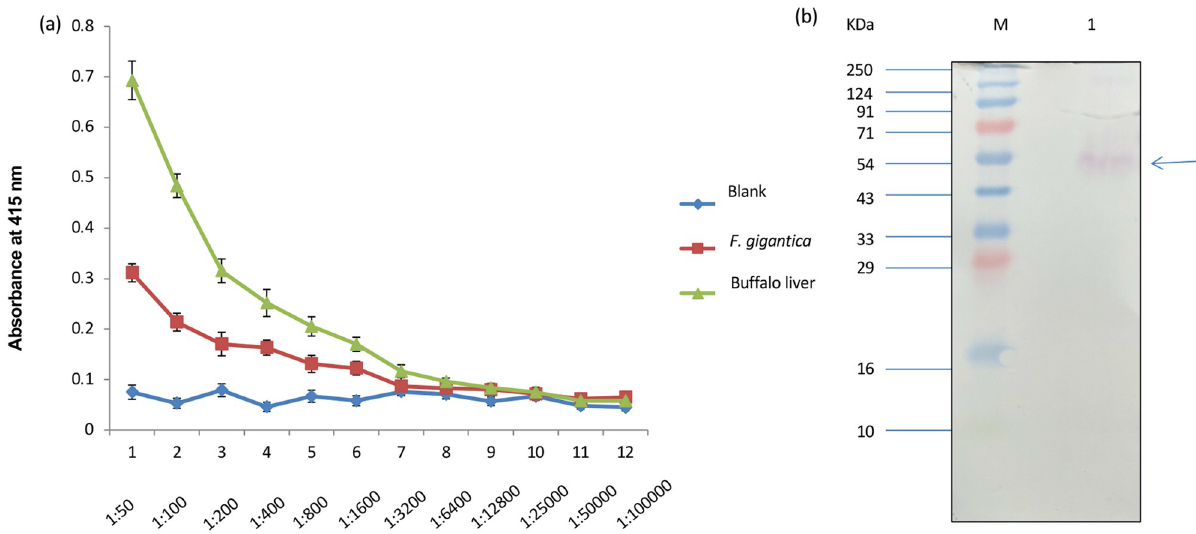
Fig 4. MAO-A was found to be highly immunogenic as revealed by high antibody titre following indirect ELISA (a) using monospecific anti MAO-A polyclonal antibodies. A distinct 50 kDa polypeptide band was also detected in the western blots (b) performed using whole homogenate (lane 1). M: standard molecular weight